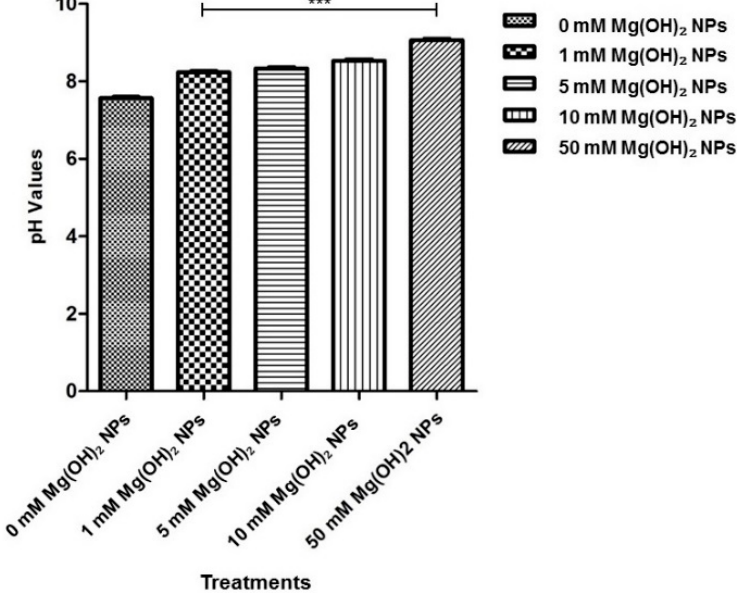
Figure 7. Analysis of the change in pH in hFOB 1.19 cells in response to the different concentrations of Mg(OH) 2 NPs. Data are obtained as means ± SEM, n = 3; *** p -value ≤ 0.0001 when compared to the control group.